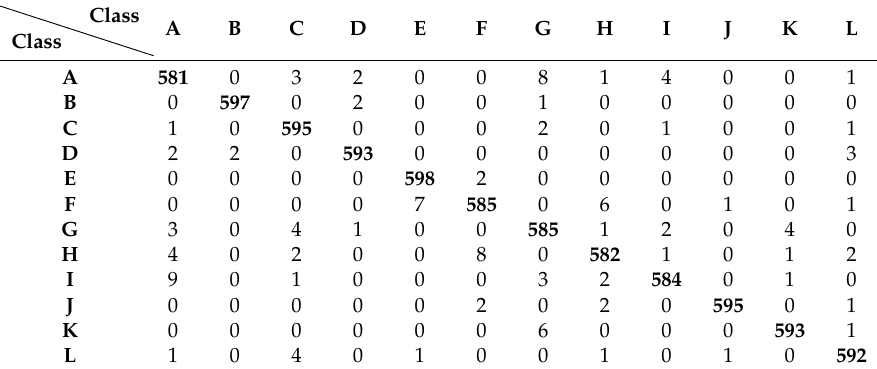
Table 17. Classification results using Random Forest secondary